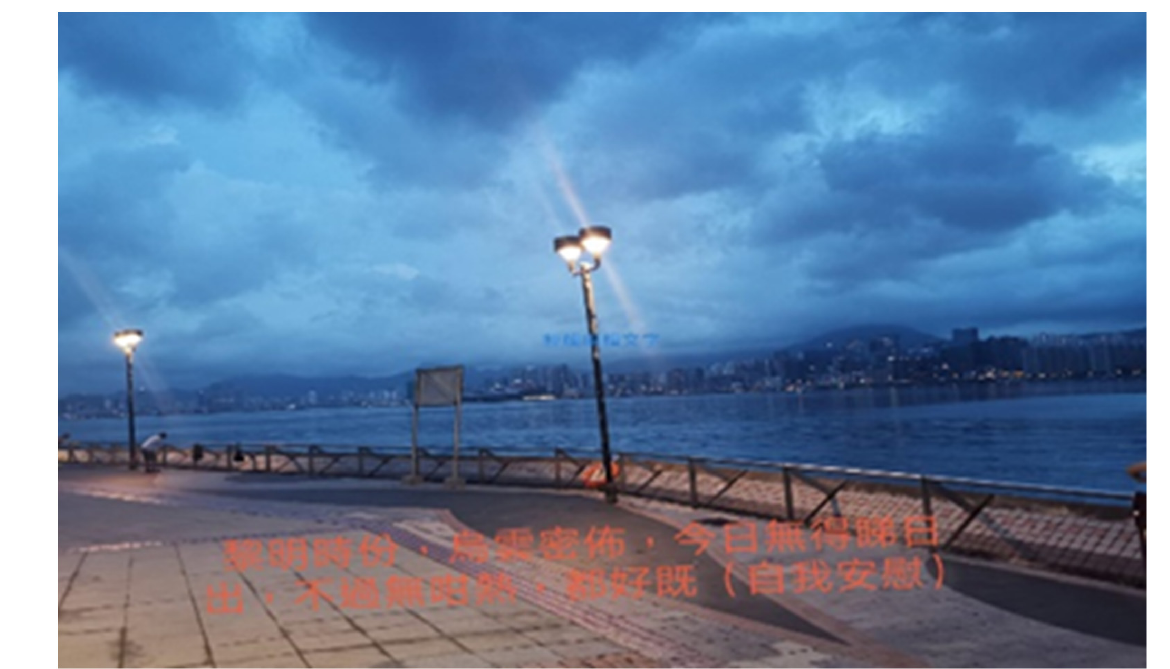
Figure 1. Photograph by Participant A.